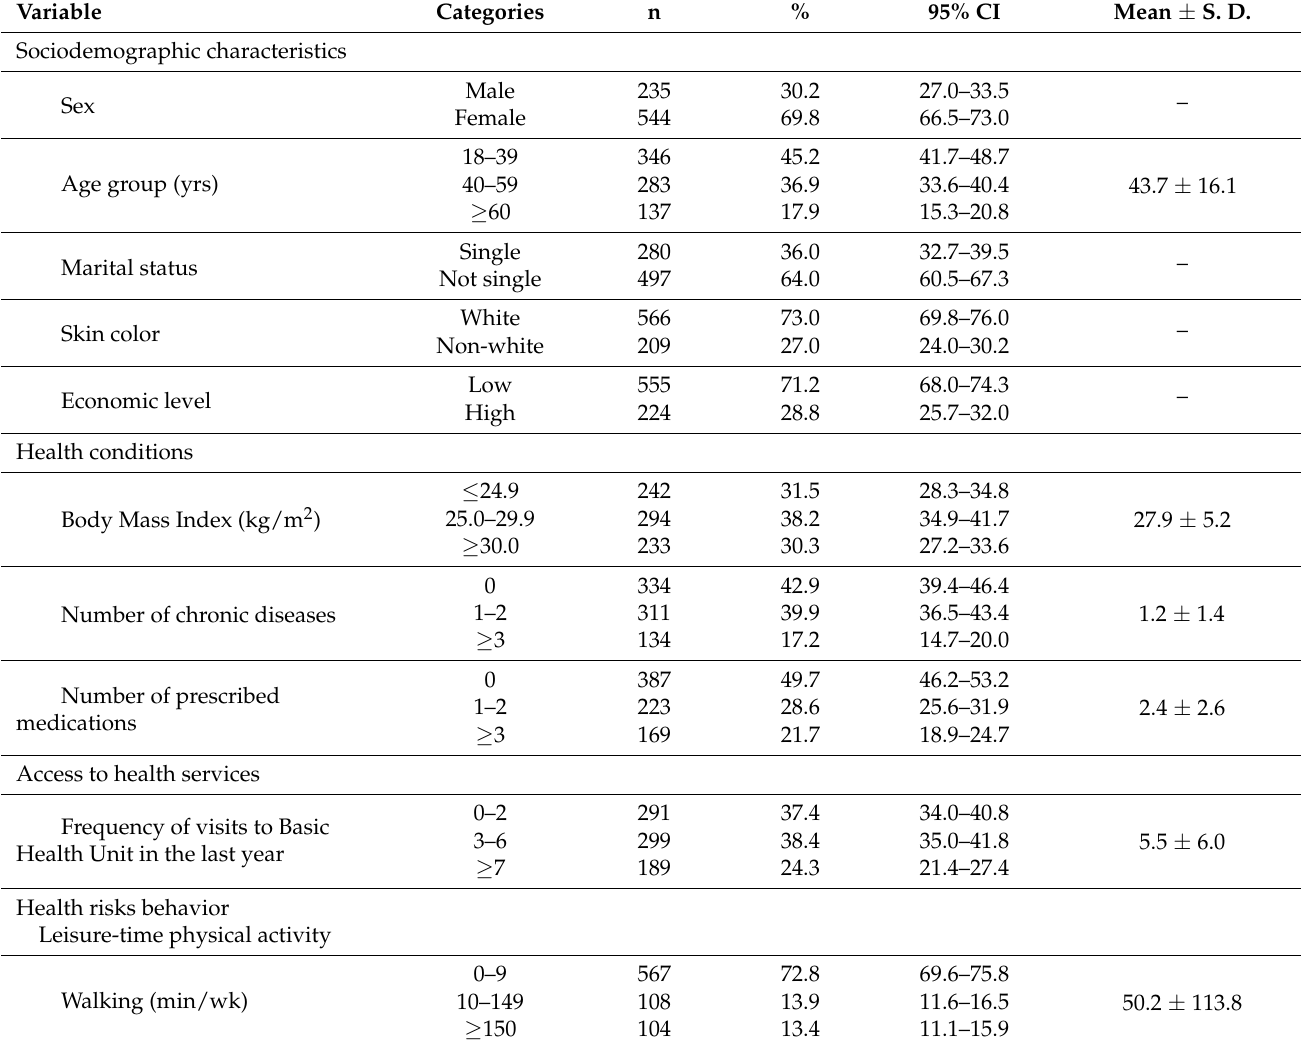
Table 1. Descriptive characteristics of adults attending basic health units. S ã o Jos é dos Pinhais, Paran á , Southern Brazil, 2019 (n =